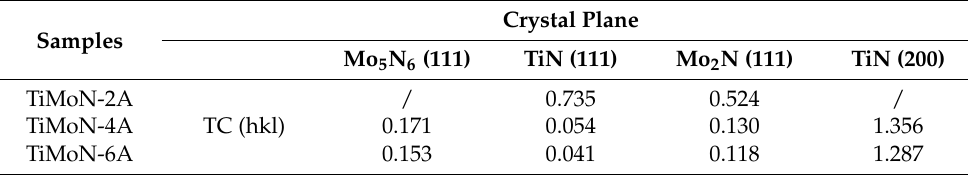
Table 4. Texture coefficients of different planes of TiMoN coatings.